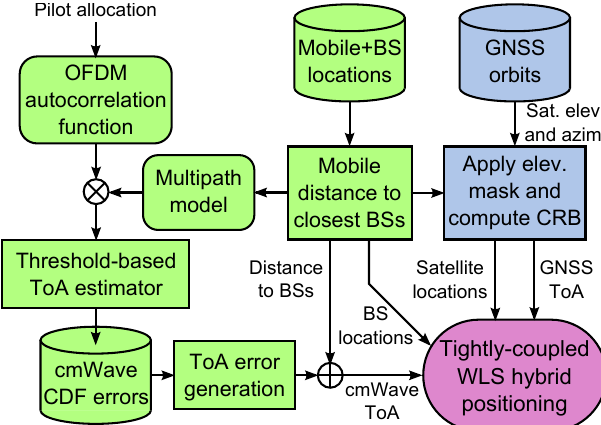
Figure 8. Simulation methodology of tightly coupled WLS hybrid GNSS and cmWave